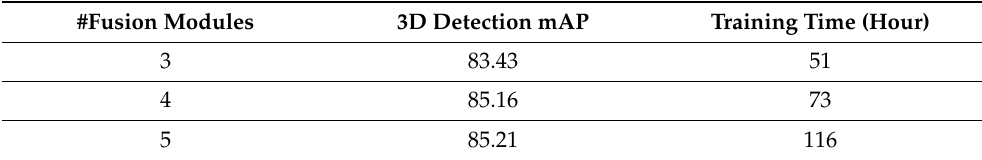
Table 4. Optimization of the number of fusion